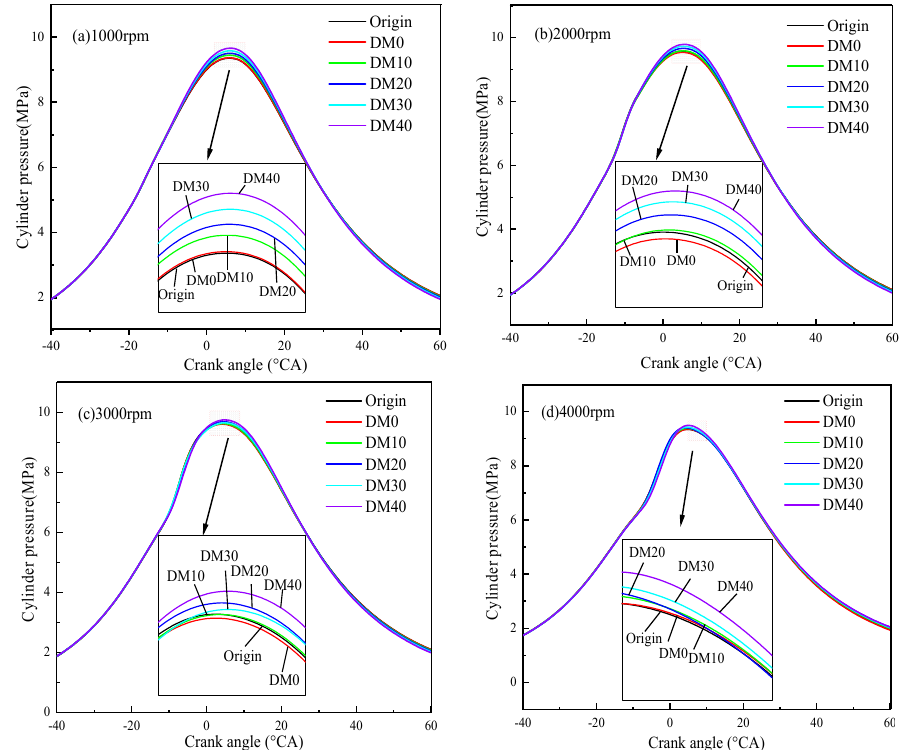
combustion pressure. In addition, methanol burns faster than diesel. Therefore, the ad- dition of methanol can increase the cylinder pressure.